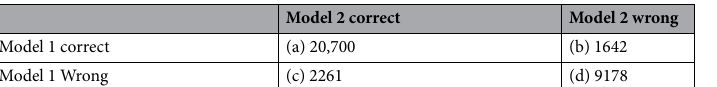
Table 2. Contingency table to calculate the chi-squared test statistic for McNemar’s test. Model 1 trained on only study characteristics features, whereas the feature set of Model 2 also includes the eligibility criteria search features and disease categorisation